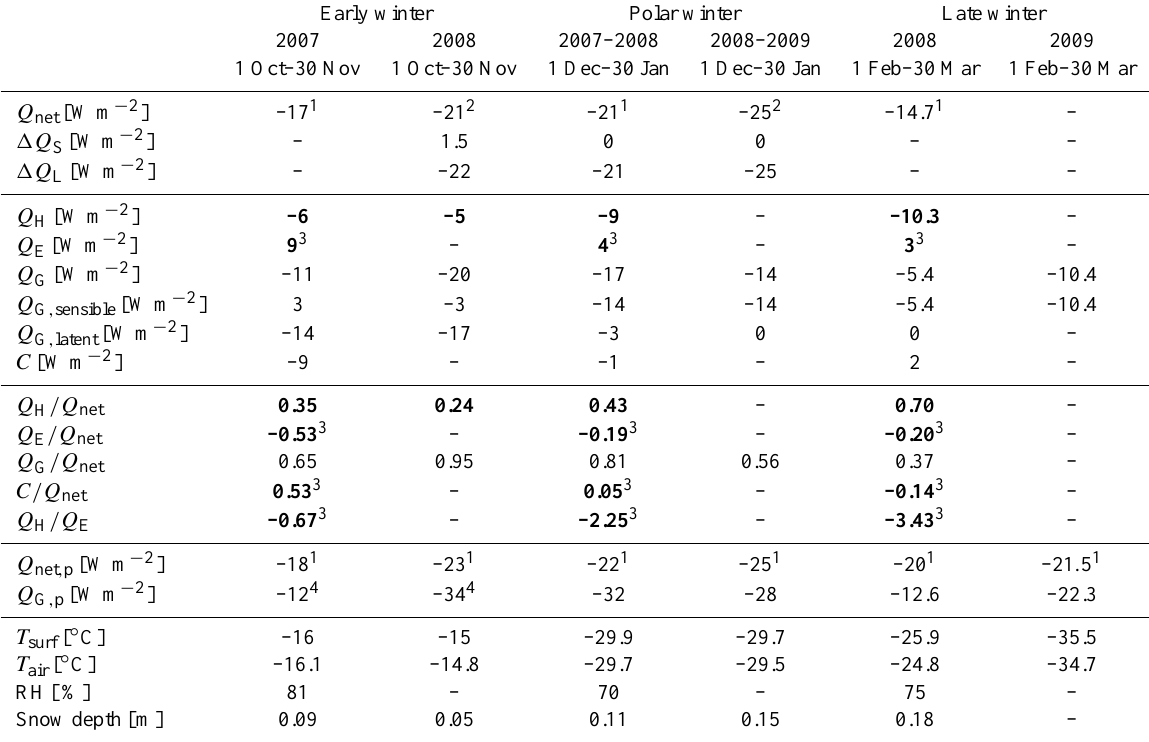
Table 2. Averages of the net radiation Q net , the net short-wave radiation 1Q S , the net long-wave radiation 1Q L , the sensible heat flux Q H , the latent heat flux Q E , the ground heat flux Q G , the sensible fraction of the ground heat flux Q G , sensible , the latent fraction of the ground heat flux Q G , latent , and the closure term C . Turbulent heat fluxes marked in bold are affected by minor data gaps due to quality assessment or the exclusion of lee wind sectors. Furthermore, averages of the net radiation Q net , p and the ground heat flux Q G , p at the pond site are